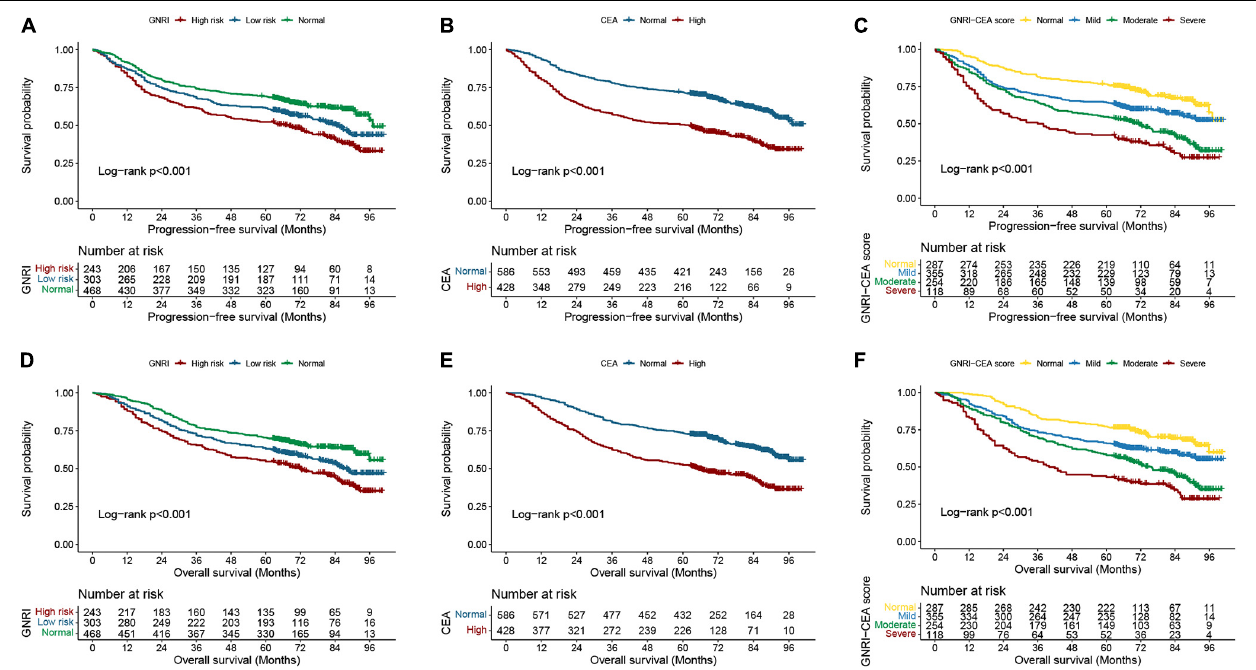
FIGURE 1 | Kaplan-Meier curve of GNRI, CEA, and GNRI-CEA score in CRC patients. (A) PFS of GNRI; (B) PFS of CEA; (C) PFS of GNRI-CEA score; (D) OS of GNRI; (E) OS of CEA; OS of GNRI-CEA score; (F) OS of GNRI-CEA score.